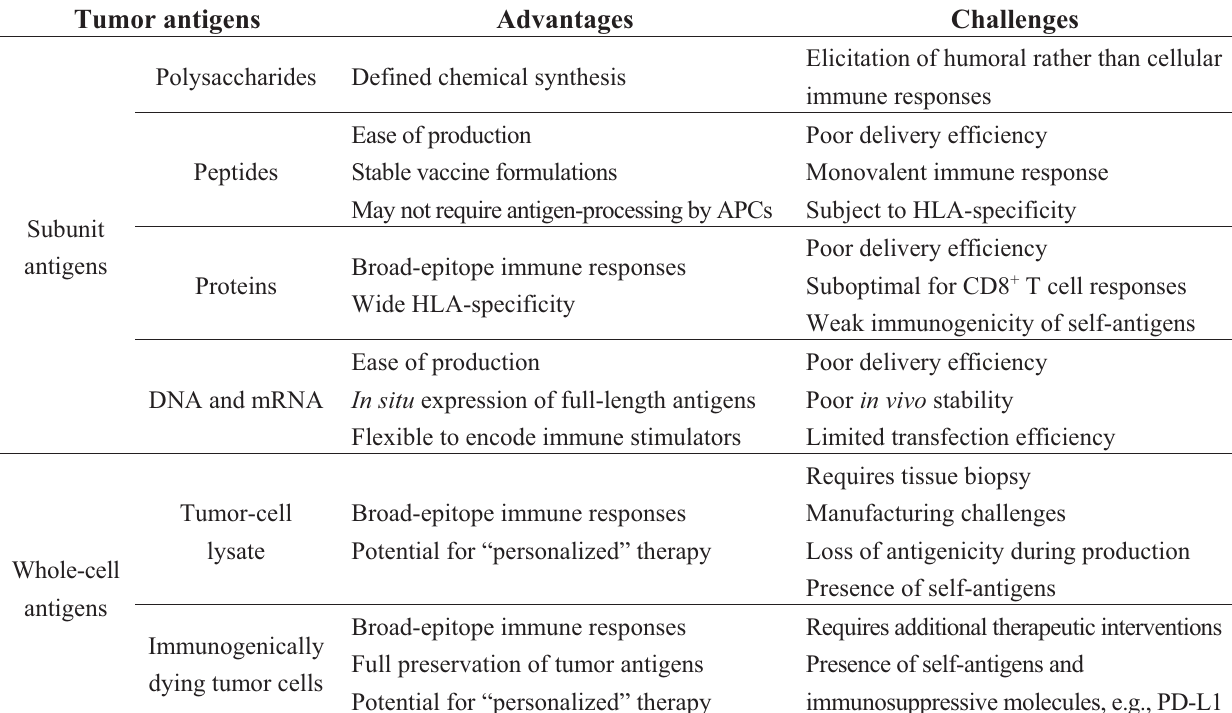
Table 1. Major advantages and remaining challenges for tumor